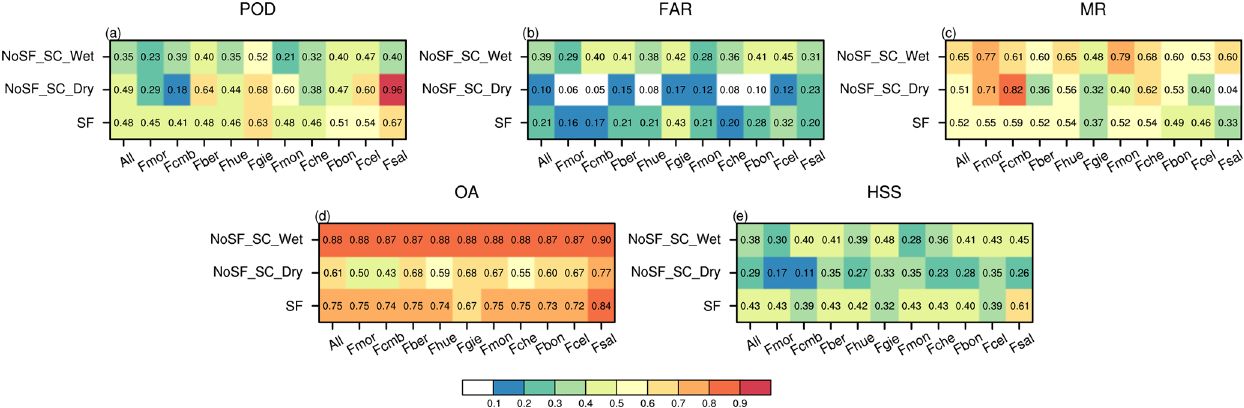
Figure 7. The POD (a) , FAR (b) , MR (c) , OA (d) and HSS (e) of SIDTM and SSDTMs assessed at Fsal station, where the maximum wind speed was relatively low (similar to Fgie, Fcel and Fber